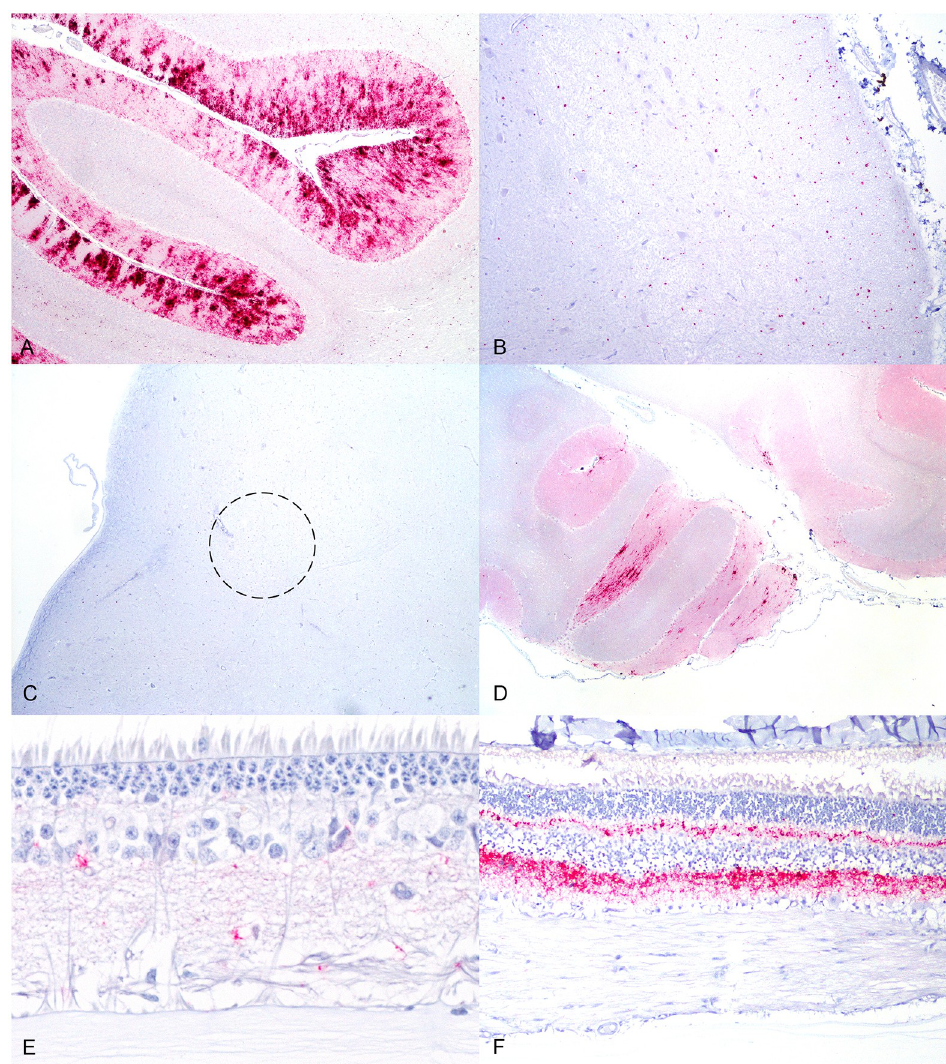
Fig 1. Immunoreactivity of PrP Sc in sheep with atypical scrapie. (A) There is a large amount of PrP Sc (red color) within the molecular layer of cerebellum in sheep 958 (ARQ/ARQ). (B) PrP Sc (red color) is confined to the spinal trigeminal tract in the medulla oblongata in sheep 948 (ARQ/ARR). (C) The dorsal motor nucleus of the vagus nerve (circle) is devoid of PrP Sc in sheep 948. (D) There are multifocal patchy aggregates of PrP Sc (red color) in the molecular layer of the cerebellum in sheep 943 (VRQ/ARQ). (E) A small amount of PrP Sc (red color) is present in the retina of sheep 943. (F) In sheep 958 there are large amounts of PrP Sc (red color) in the plexiform layers of the retina. contrast, the single positive VRQ/ARQ sheep was IHC positive and EIA negative in the cere- bellum. This discrepancy was presumably due to the patchy and sparse distribution of PrP Sc in the cerebellum (Fig 1D). PrP Sc was rarely observed in other brain regions of this animal; how- ever, PrP Sc was detected in the retina with IHC (Fig 1E). Moreover, retinal PrP Sc was present in each genotype of sheep with atypical scrapie PrP Sc in the cerebellum. In clinical sheep with abundant cerebellar PrP Sc , there were large amounts of PrP Sc in the retina (Fig 1F). PrP Sc occurred mostly in the inner and outer plexiform layers, but some minimal labeling was seen in the ganglion and nuclear cell layers. Other reports that describe atypical scrapie do not report retinal PrP Sc [1–5, 14–16, 25, 26]. In this study, sheep intracranially inoculated with the